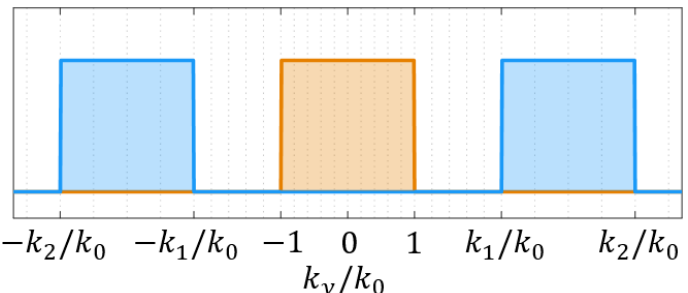
Figure 2. The desired portions of the normalized spatial frequency spectrum are highlighted as the blue regions. To mitigate radiation, there should be negligible contributions in the propagating wave region, highlighted in